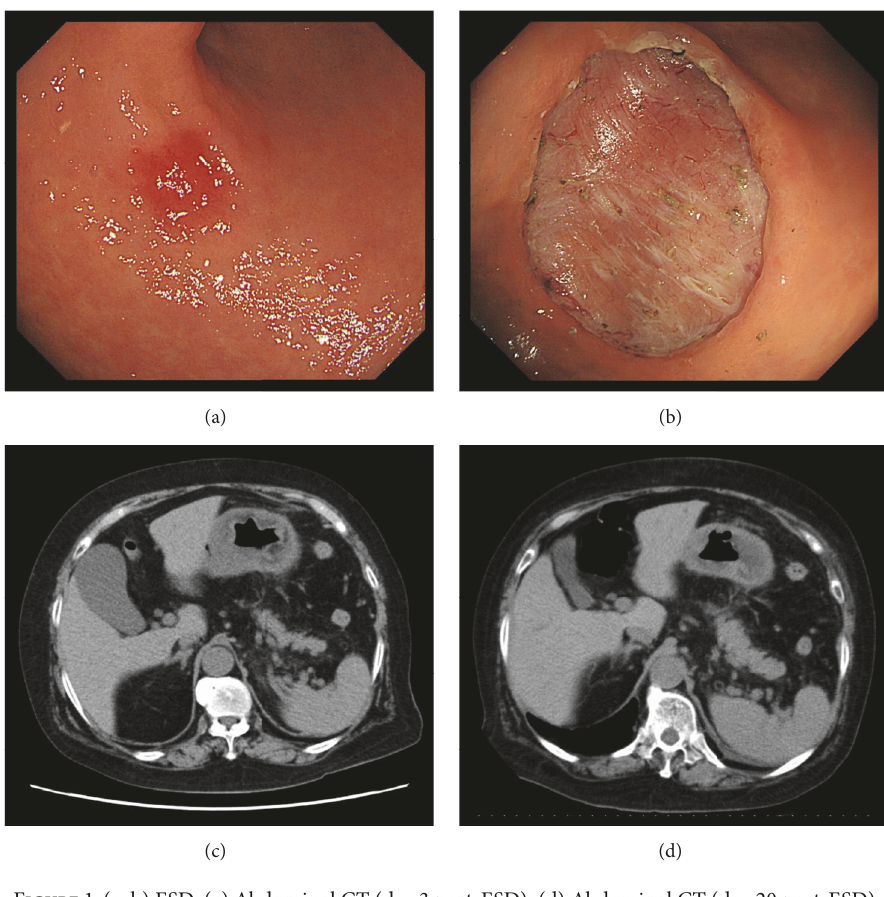
Figure 1: (a, b) ESD. (c) Abdominal CT (day 3 post-ESD). (d) Abdominal CT (day 20 post-ESD).